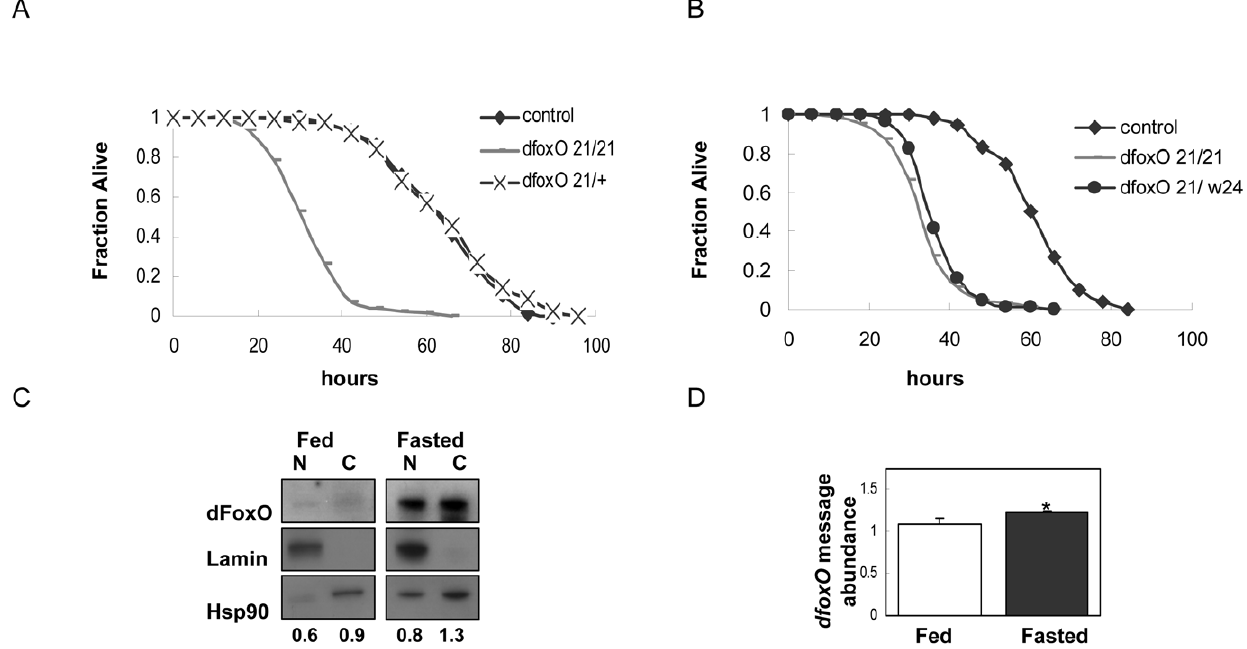
Figure 1. RelativedFoxO protein increases and confers survival during fasting. Null mutants homozygous ( A ) dfoxO 21 and ( B ) trans- heterozygous dfoxO 21 / dfoxO w24 have reduced survival during fasting relative to wild type and dfoxO 21 / + . ( C ) Sub-cellular localization of dFoxO in decapitated bodies of fed and fasted females. Lysates were analyzed by Western immunoblot for dFoxO, Lamin as nuclear (N) and Hsp90 as cytosolic (C) controls. Numbers indicate the quantification by densitometry to obtain the ratio dFoxO to Lamin in N, or Hsp90 in C. dFoxO nuclear quantification was corrected for contamination by subtracting Hsp90 from nuclear fractions. Likewise, Lamin in the cytosol was subtracted from the dFoxO cytosolic quantifications. The nuclear fraction lane from the fasted samples shows a prominent Hsp90 band that we have considered contamination. However, Hsp90 may translocate to the nucleus upon fasting. In that situation, the ratio dFoxO to Lamin would be higher that 0.8. ( D ) dfoxO mRNA abundance from decapitated bodies of fed and fasted females flies. Relative gene expression was analyzed by 2 2 DD CT method [33]. Data are shown as the mean + 1 standard deviation. *, P , 0.05 versus control.